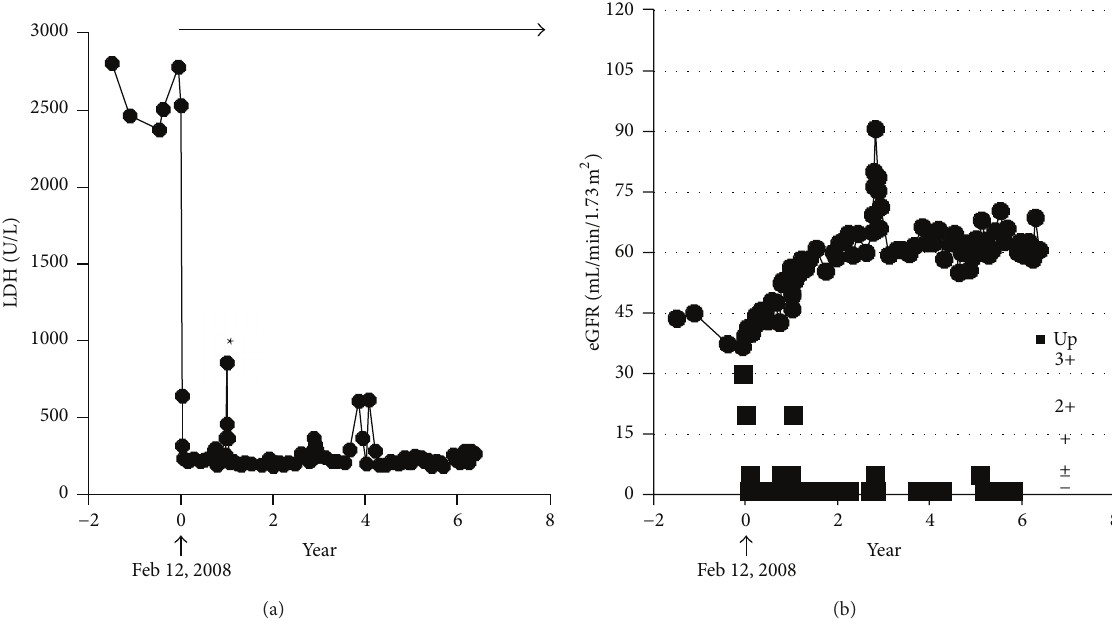
Figure 1: Clinical course of the patient. On February 12, 2008, he was enrolled in the AEGIS clinical trial. (a) Administration of eculizumab resulted in a rapid reduction of LDH. Asterisk indicates the increased LDH due to delayed administration of eculizumab during an AE of hyperbilirubinemia. Arrow indicates eculizumab treatment. (b) He was complicated with stage 3 CKD, grade G3b, and obvious proteinuria, at baseline. Eculizumab treatment improved eGFR gradually. Since two years after introduction of eculizumab, eGFR at grade G2 and no proteinuria have been maintained. Closed squares denote grades of proteinuria ( − , ± , +, 2+, and